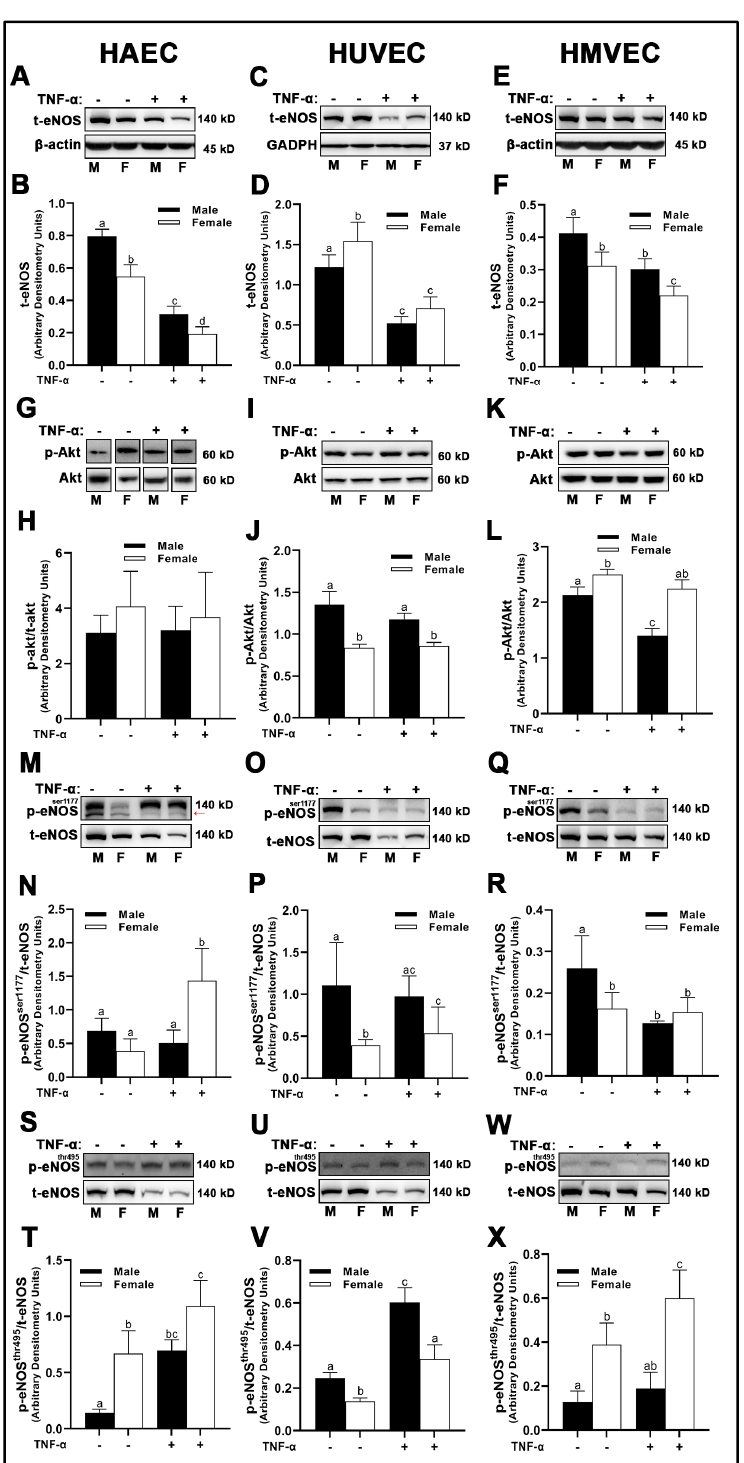
Figure 9. Regulation of eNOS in male and female endothelial cells. HAECs, HUVECs and HMVECs were cultured in starvation medium at ~80% confluency for 24 h with or without TNF- α (20 ng/mL). Protein expression of t-eNOS ( A – F ), p-akt ( G – L ), p-eNOS Ser1177 ( M – R ) and p-eNOS Thr495 ( S – X ) were determined by Western blot. Quantification was performed using Image Lab (Bio-Rad Laboratories, Inc.). Band expression of t-eNOS and t-akt were normalized to respective control bands ( β -actin or GAPDH). For phosphorylated proteins that were not probed on the same membrane as their respec- tive total proteins, they were first normalized to control proteins ( β -actin or GAPDH) followed by normalization with their respective normalized total proteins from a separate membrane. Data are